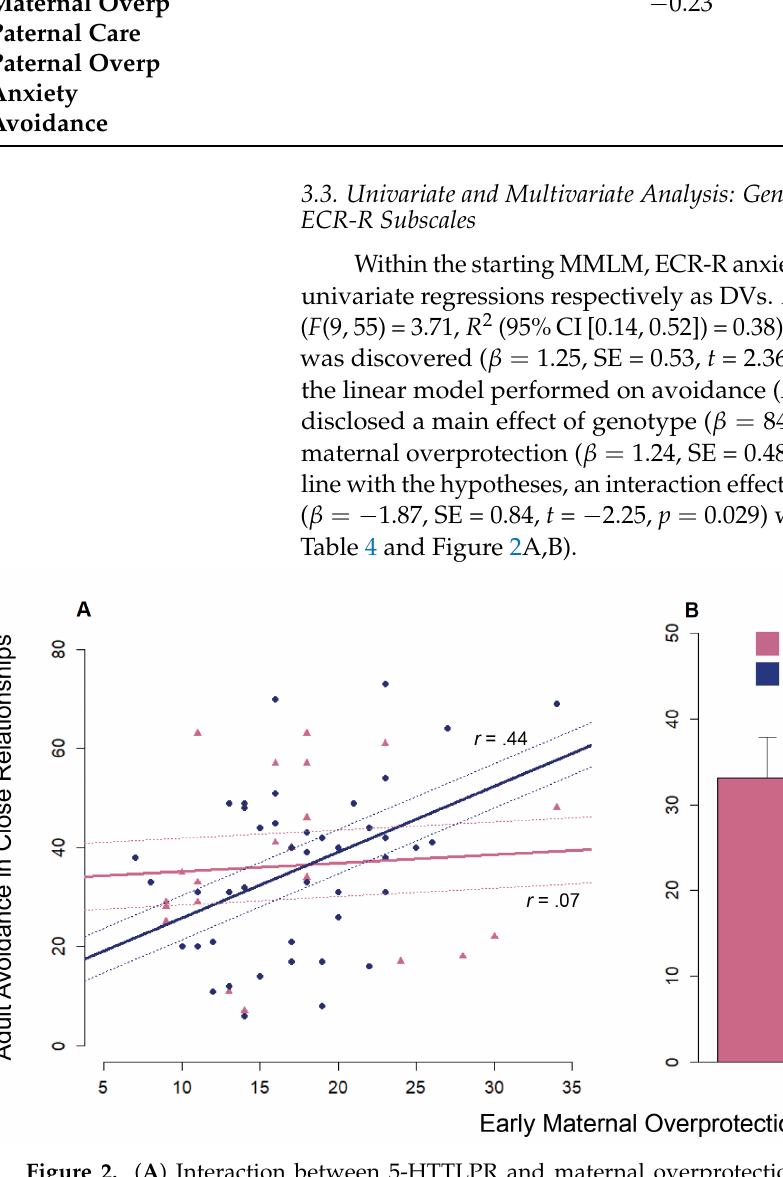
Figure 2. ( A ) Interaction between 5-HTTLPR and maternal overprotection on avoidance. Pearson r coefficients be- tween the avoidance scores and the recalled maternal overprotection for each genetic group. Blue circles = L-carriers; pink triangles = S/S. Continuous lines represent the linear models for L-carriers (blue) and S/S homozygous (pink). Dashed lines represent the standard error of the regression lines for L-carriers (blue) and S/S homozygous (pink). ( B ) Avoidance mean scores in L-carriers (blue) and S/S homozygous (pink) by low and high maternal overprotection. When the two ECR-R subscales were considered in multivariate analysis through the MANCOVA for MMLM, both genotype (Pillai test statistics = 0.13, approximated F (2, 54) = 4.12, p = 0.02, p η 2 = 0.13) and maternal overprotection (Pillai test statistics =